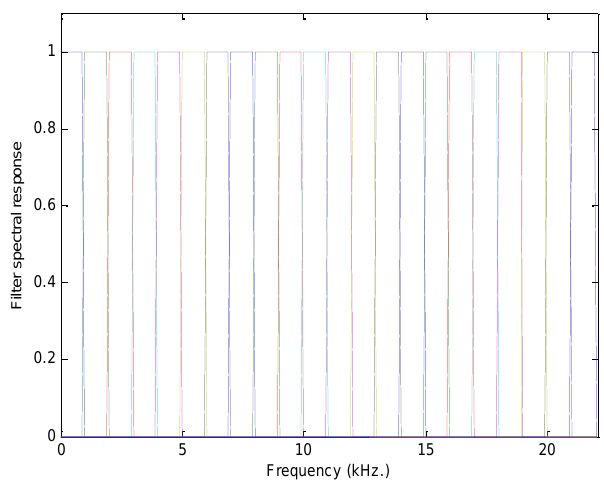
Figure 8. Bank of rectangular filters with a constant 1 kHz bandwidth.